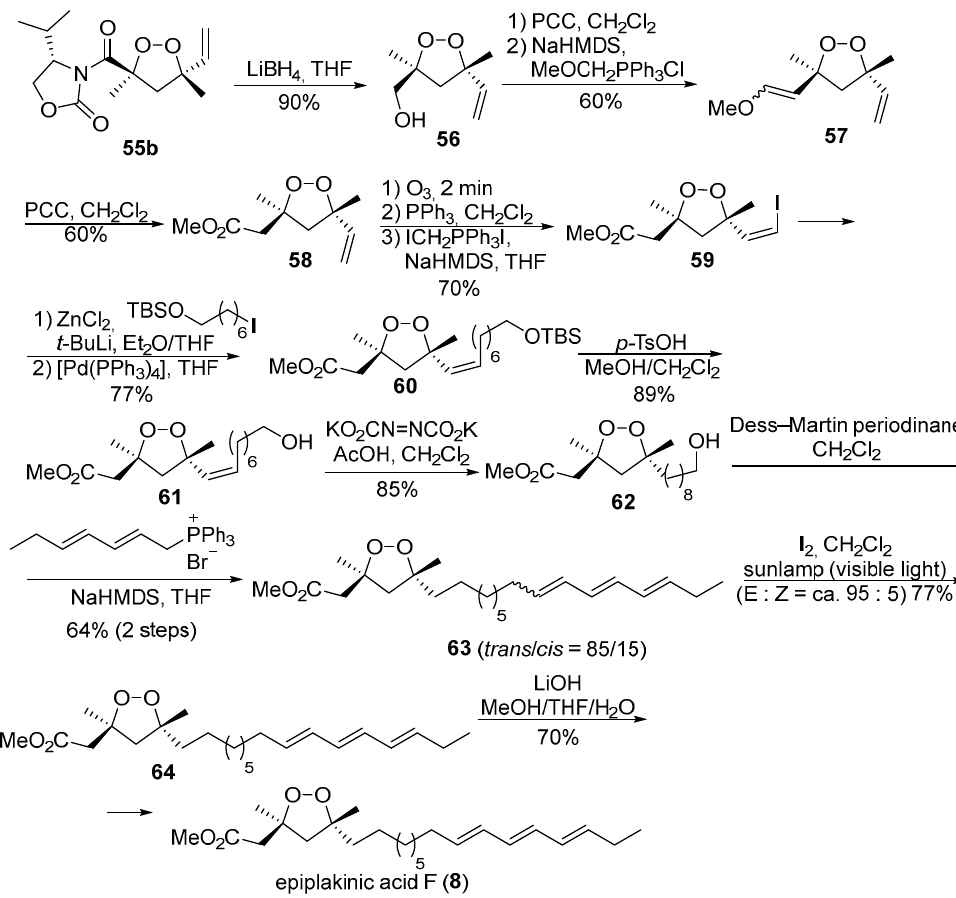
Scheme 8. Asymmetric synthesis of epiplakinic acid F ( 8 ).